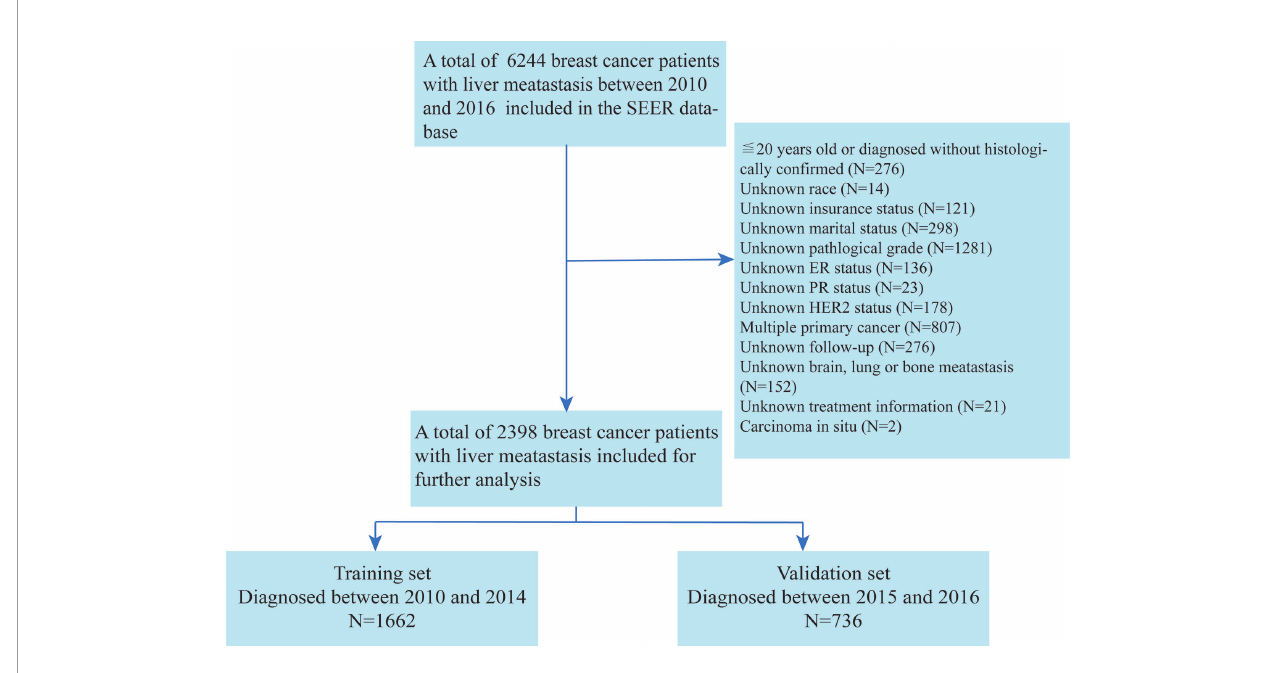
FIGURE 1 | Selection of